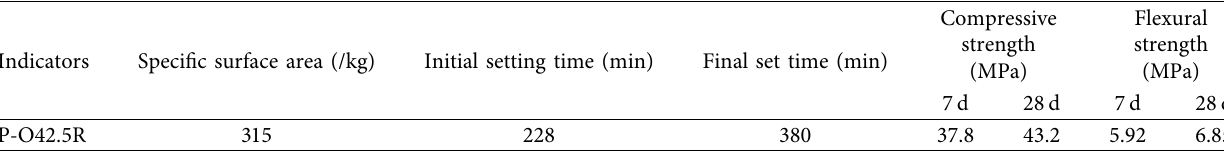
Table 1: Cement test indicators.